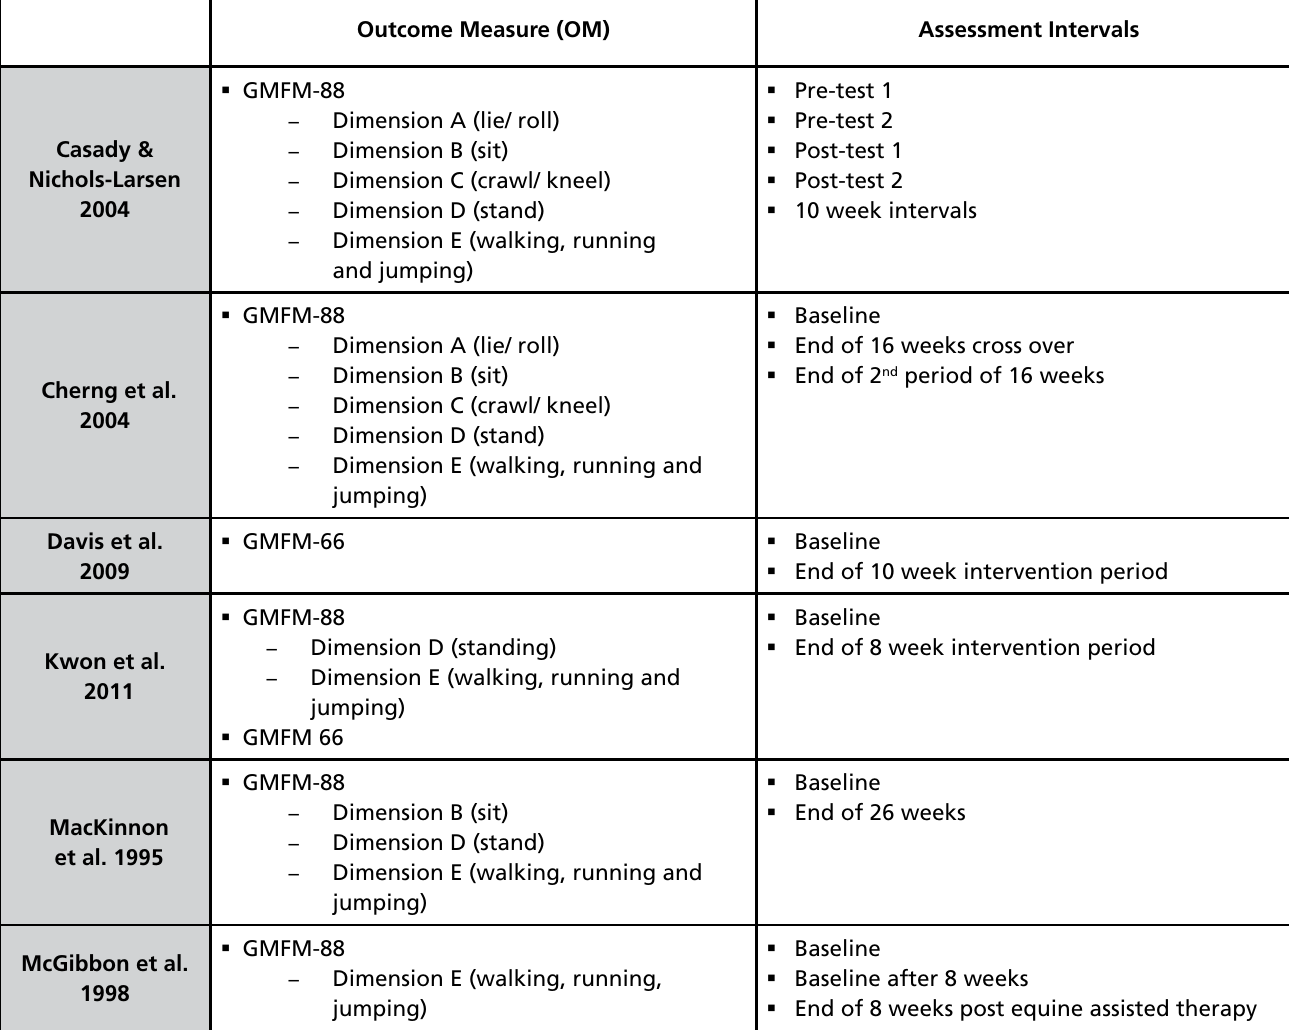
table 4: Description of outcome measures used to measure gross motor function, as well as follow-up measurement intervals Outcome Measure (OM) assessment